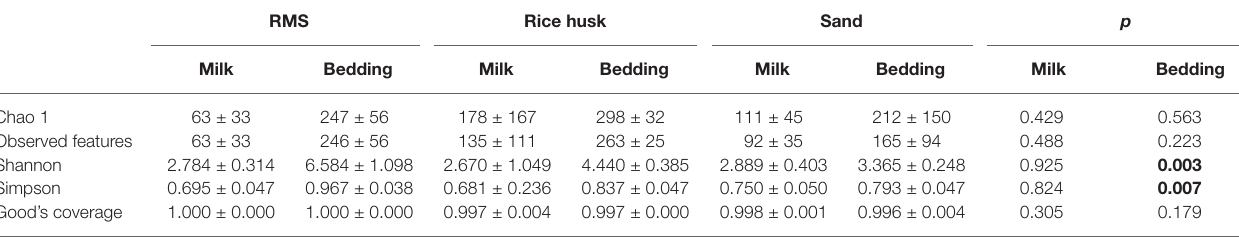
TABLE 2 | One-way ANOVA of bacterial α -diversities of the microbiota in milk and bedding from different